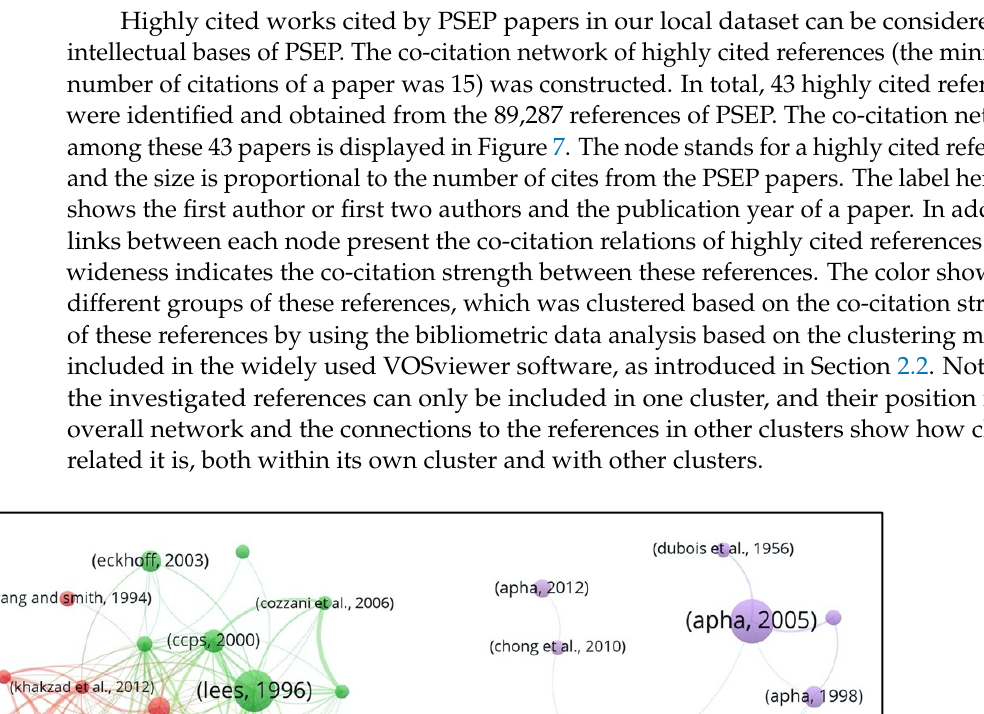
Figure 8. Keyword co-occurrence cluster of PSEP papers.